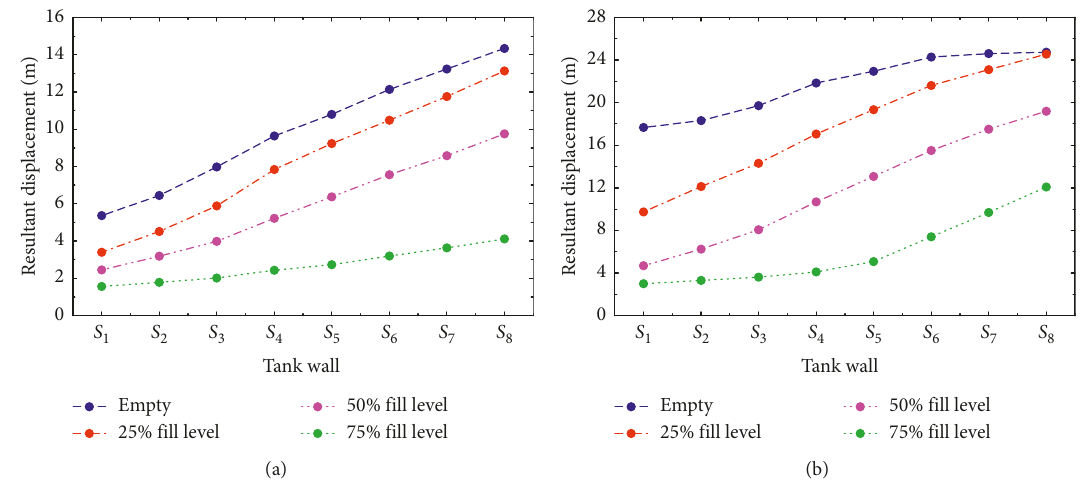
Figure 12: Resultant displacement of measuring points S TNT equivalent mass explosion.